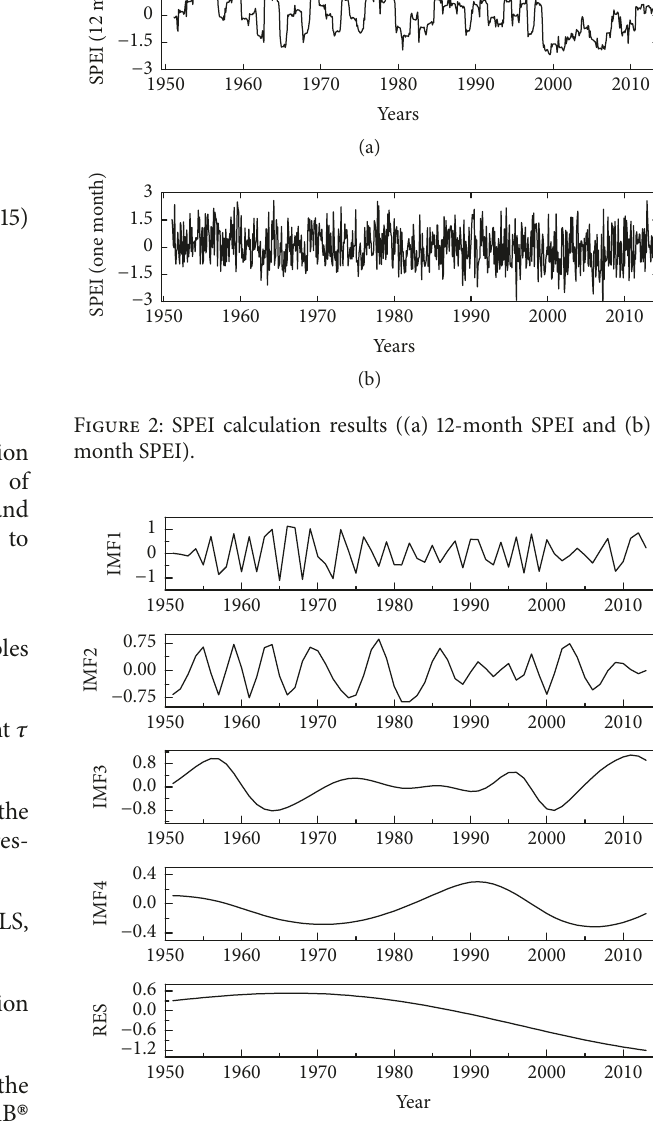
Figure 3: EMD results for the 12-month